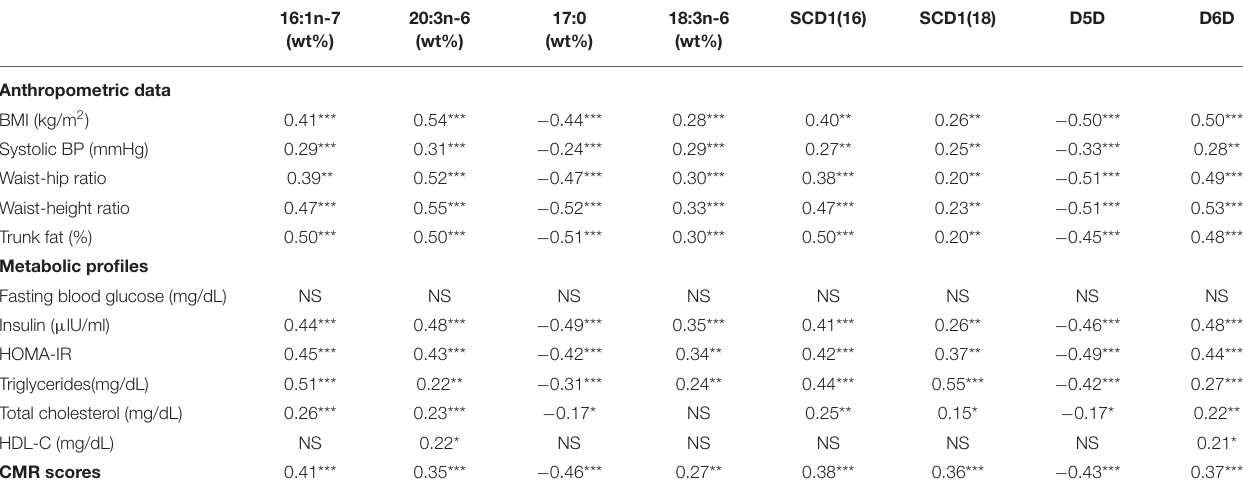
TABLE 3 | Correlation coefficient between single fatty acid proportions, estimated desaturase activities, and selected metabolic risk factors.